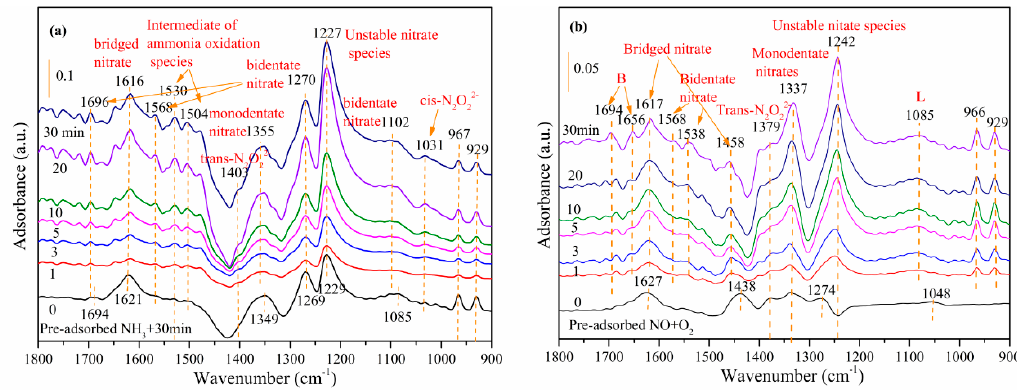
Figure 5. In-situ DRIFT spectra of ( a ) NO + O 2 reacted with pre-adsorbed NH 3 , and ( b ) NH 3 reacted with pre-adsorbed NO + O 2 over the Mn 0.15 Fe 0.05 /FA at 150 °C.